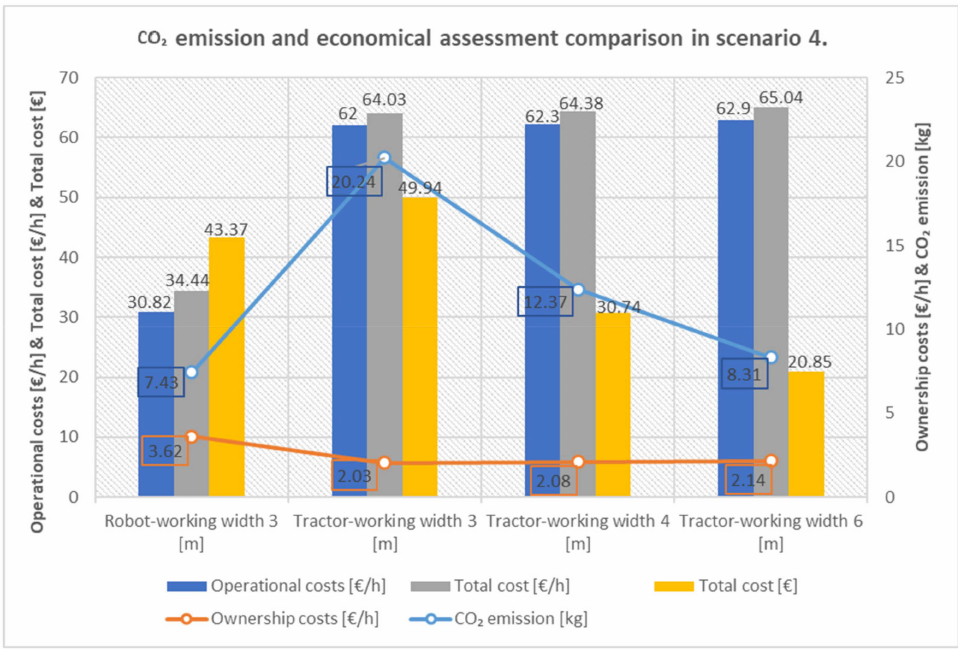
Figure 23. The comparison of fuel and oil consumption for the robot and the tractor in weeding operation. Based on Figure 24, the comparison of operational costs shows that the robot has up to 51% less operational cost per hour than the tractor. A comparison of total costs per hour shows that the robot has up to 47% less total cost per hour than the tractor. The results shows that the tractor with 6 m working width has the lowest total cost. Moreover, the comparison of CO 2 emission shows that the robot has up to 63% less CO 2 emission than the tractor in weeding operation.